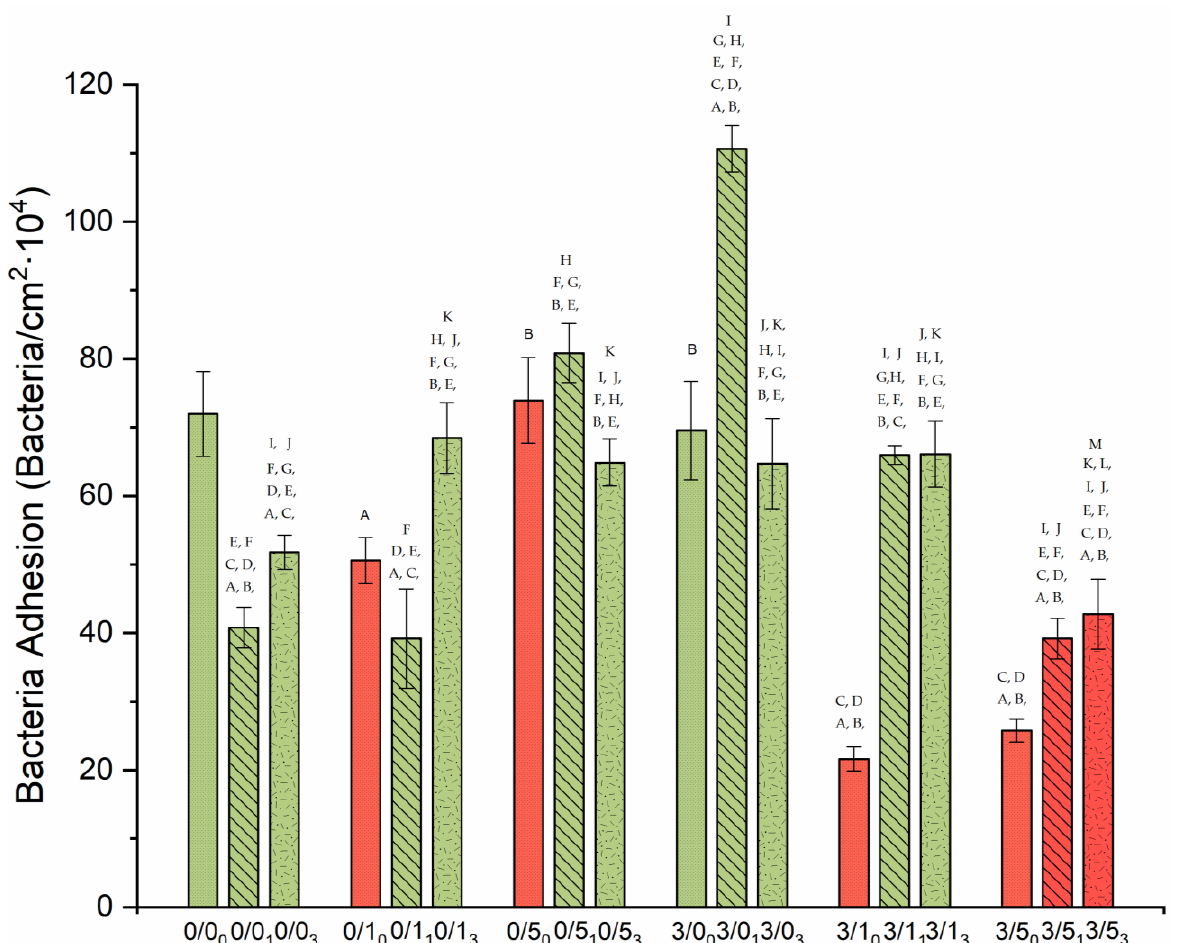
Figure 6. Bacterial density adhered to the surface of the PLA samples. The smooth bars are those given to the non-degraded samples, the diagonally hatched bars are for the samples degraded for one month, and lastly, the notched bars are for the samples degraded for 3 months. Likewise, the color given to each bar represents the viability of the adhered bacteria, green for the viable ones and red for the damaged ones. Statistical difference ( p < 0.05) is marked with the different letters depending on which sample it is compared with. The letters A is used to 0/0 0 ; B is used to 0/1 0 ; C is used to 0/5 0 ; D is used to 3/0 0 ; E is used to 3/1 0 ; F is used to 3/5 0 ; G is used to 0/0 1 ; H is used to 0/1 1 ; I is used to 0/5 1 ; J is used to 3/0 1 ; K is used to 0/0 3 ; L is used to 0/5 3 ; M is used to 3/0 3 .